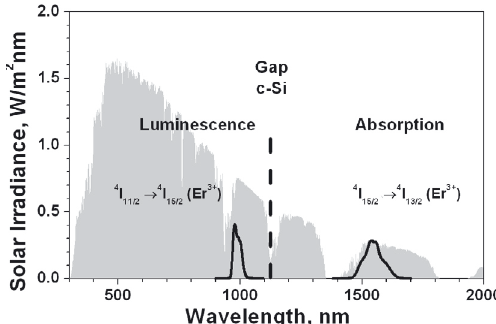
Fig. 1. Er 3+ Absorption from the ground state to the first excited state ( 4 I 15 / 2 → 4 I 13 / 2 ) and upconverted emission in the near infrared (( 4 I 11 / 2 → 4 I 15 / 2 ) in comparison with the AM1.5G solar